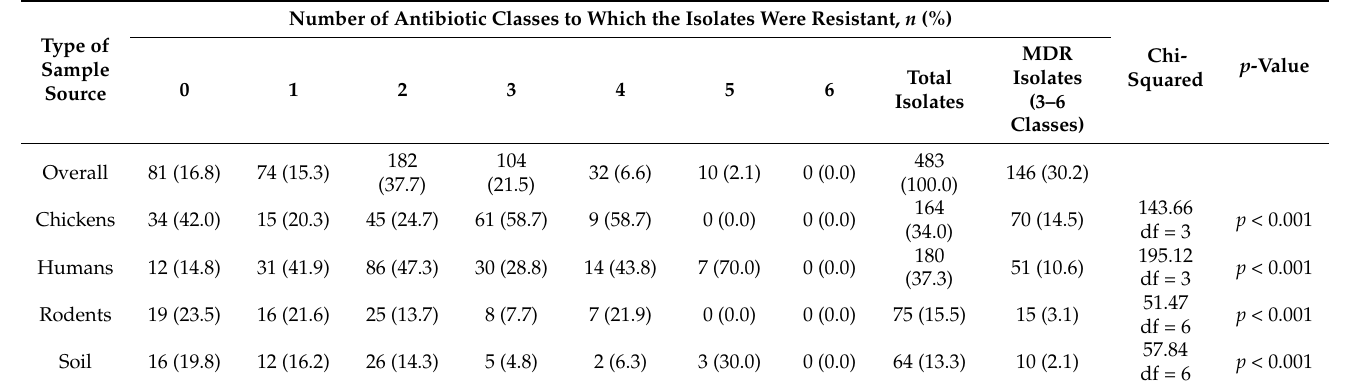
Table 3. MDR rates of S. aureus isolates from different types of samples.